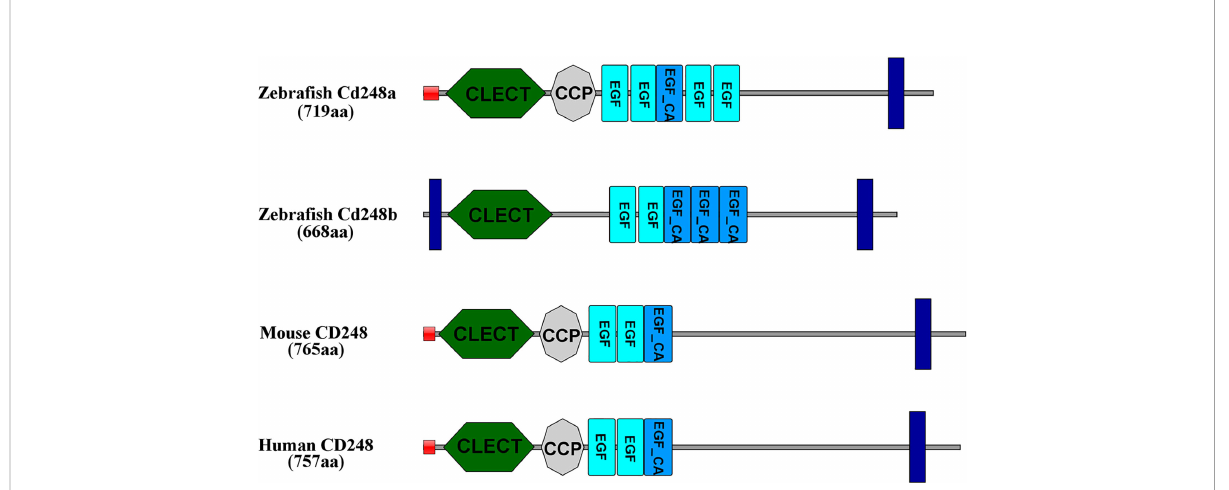
FIGURE 1 Amino acid functional domains of CD248 protein in human, mouse and zebra fi sh. Red squares, signal peptide; Blue rectangles, transmembrane region; CLECT, C-type lectin domain; EGF, epidermal growth factor-like domain; EGF_CA, Calcium-binding EGF-like domain; CCP, complement control protein